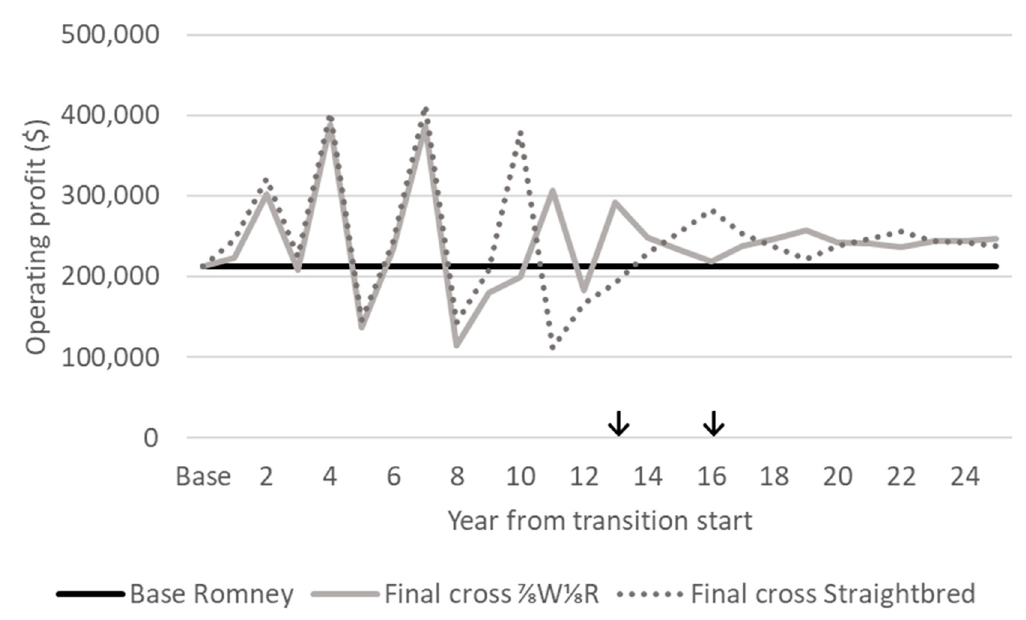
Figure 8. Annual operating profit during a grading up transition from base Romney to a desired final cross of either a). ⅞ W ⅛ R or b). Straightbred, with the base Romney operating pro fi t for comparison. ↓ Where the grading up transition period has finished and the desired fi nal cross fl ock ( ⅞ W ⅛ R or straightbred) has reached an equivalent feed demand to the base Romney flock.